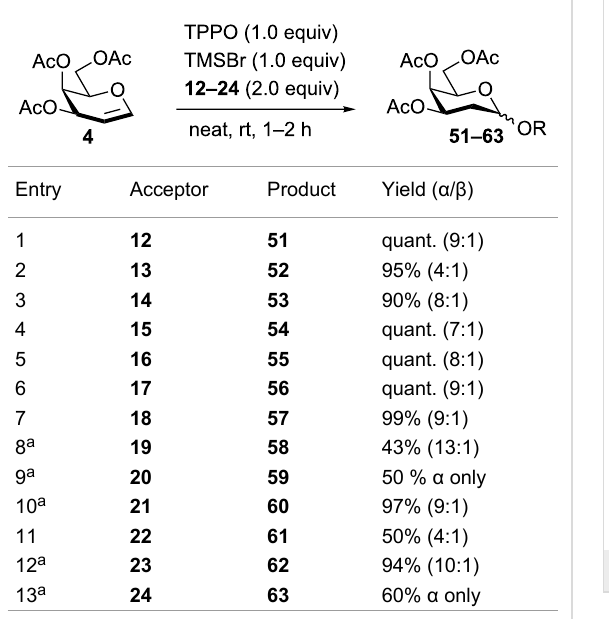
Table 4: TMSBr-mediated 2-deoxyglycosylation of O -acetyl galactal 4 .